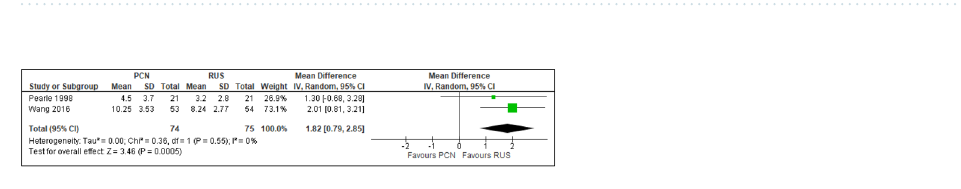
Figure 6. Comparison between PCN and RUS for outcome hospitalisation